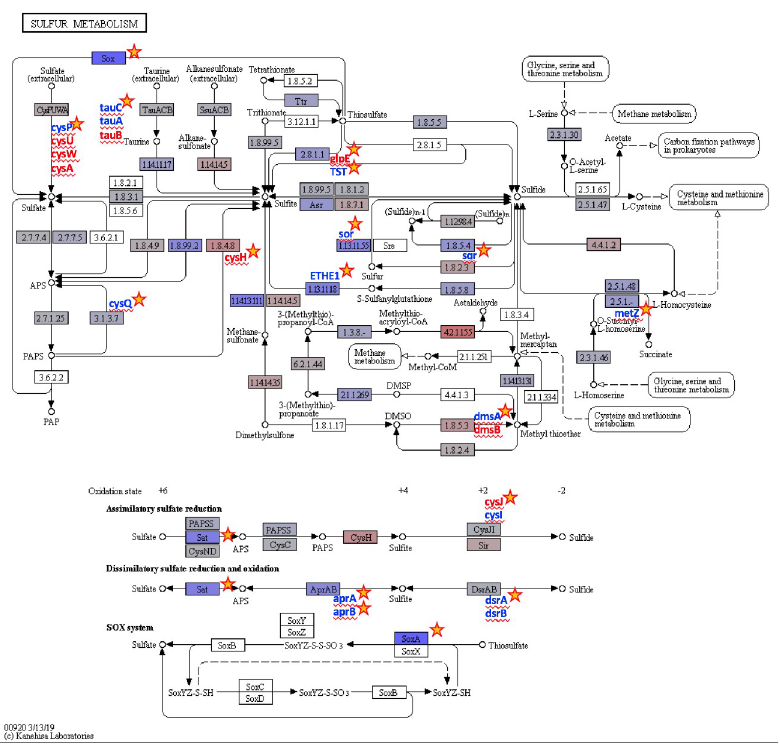
Fig 4. Sulfur metabolism gene expression. Sulfur metabolism KEGG reference pathway map diagram (https://www. kegg.jp/pathway/map00920) with color gradation highlighting KEGG-annotated gene expression that changes between seasons. Blue and red colors denote decreased and increased abundance of RNA transcripts in the winter, respectively. Genes that did not change are light gray and undetected genes are white. Significantly differentially expressed genes are indicated by a star and met the following criteria: p-interaction � 0.05 in combination with a q- winter/summer RNA � 0.05, respectively.